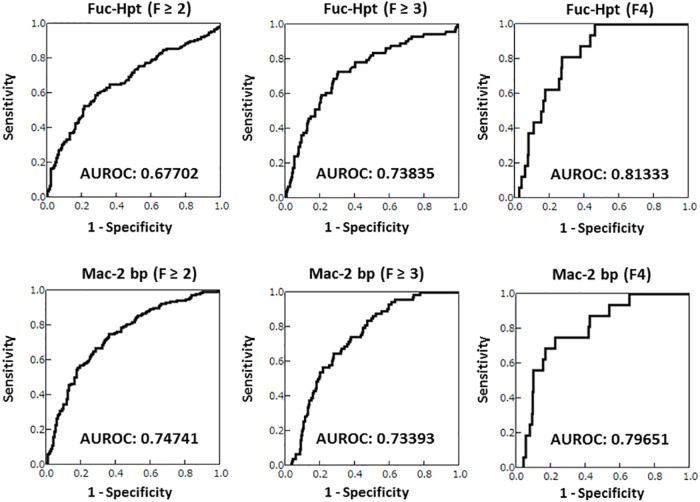
The diagnostic abilities of the serum Fuc-Hpt and Mac-2 bp levels for assessing the stage of liver fibrosis.The ROC curves and AUROC values of serum Fuc-Hpt and Mac-2 bp in F ≥ 2, F ≥ 3 and F4 stage liver fibrosis were shown in the figure.